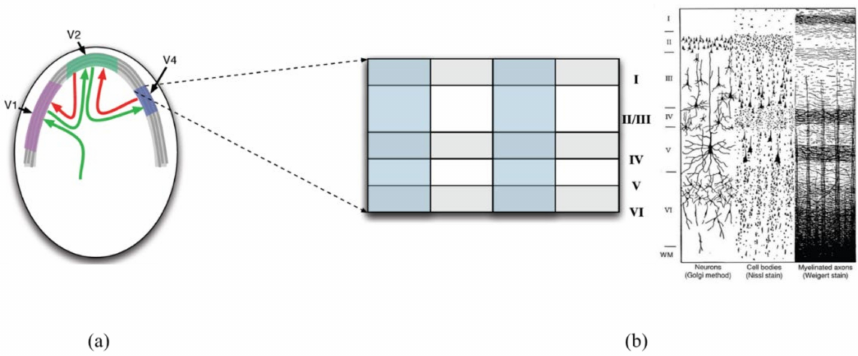
Figure 5. Structure of neocortex region of human brain [13,15]. ( a ) Visual cortex regions such as V1, V2, and V4, ( b ) A small part of vertical section of neocortex sheet.